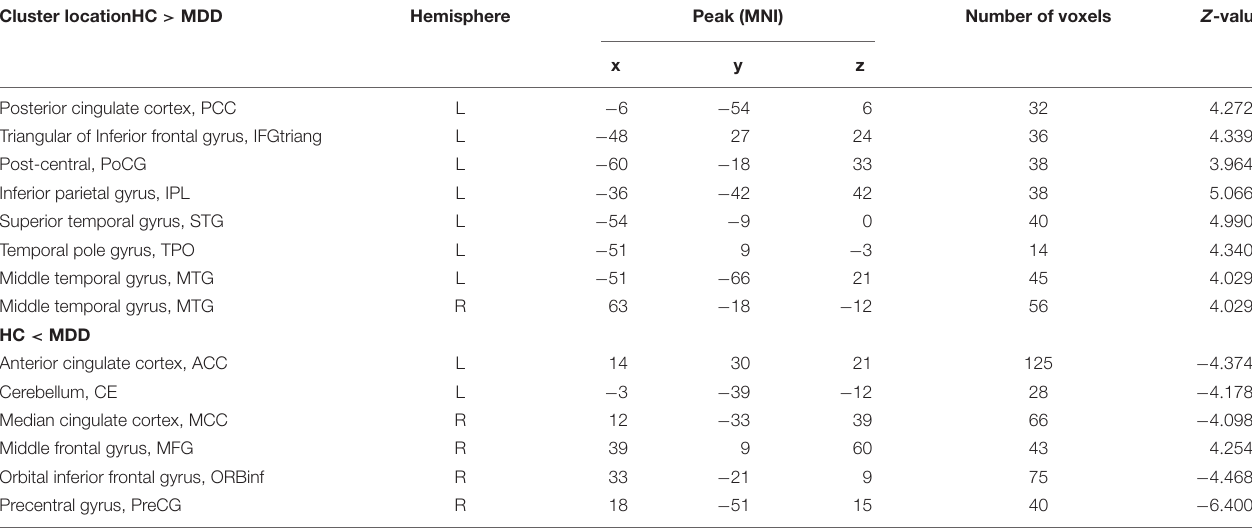
TABLE 2 | Regional homogeneity analysis between MDD and HC